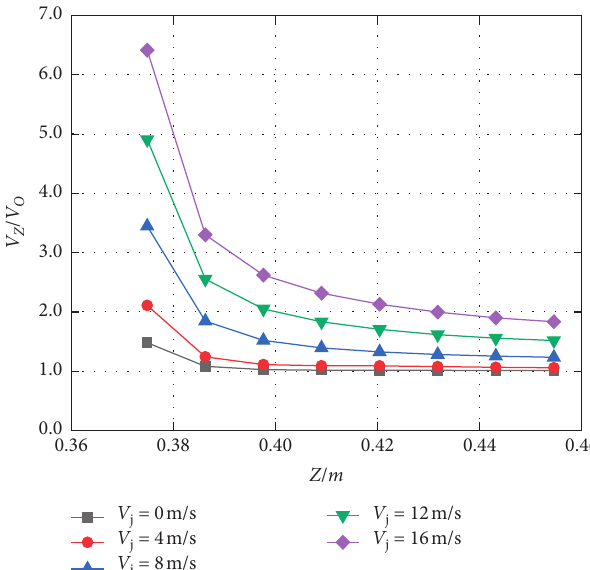
Figure 7: Speed change on the central axis.